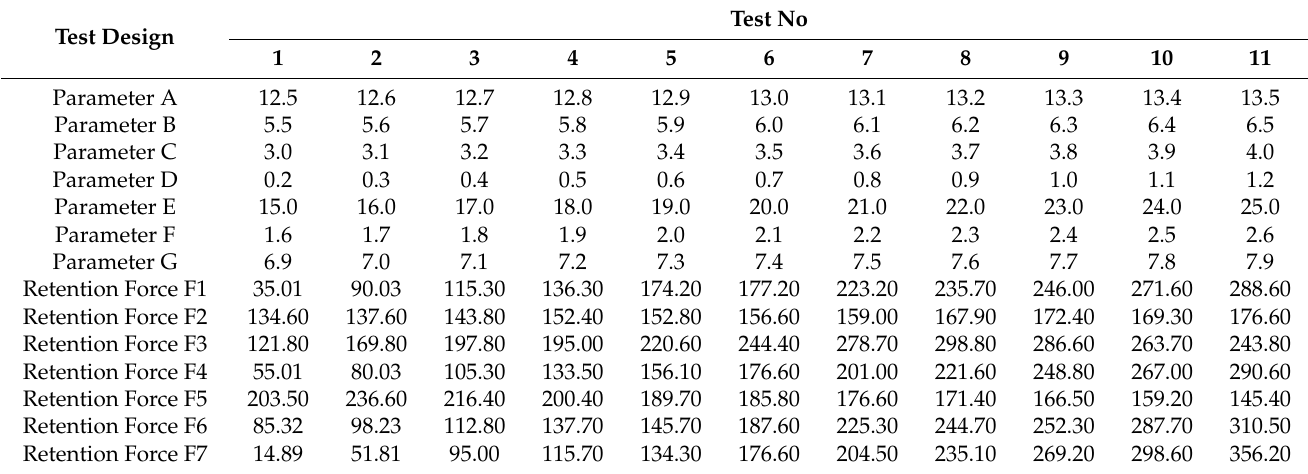
Table 9. Retaining force under each parameter.